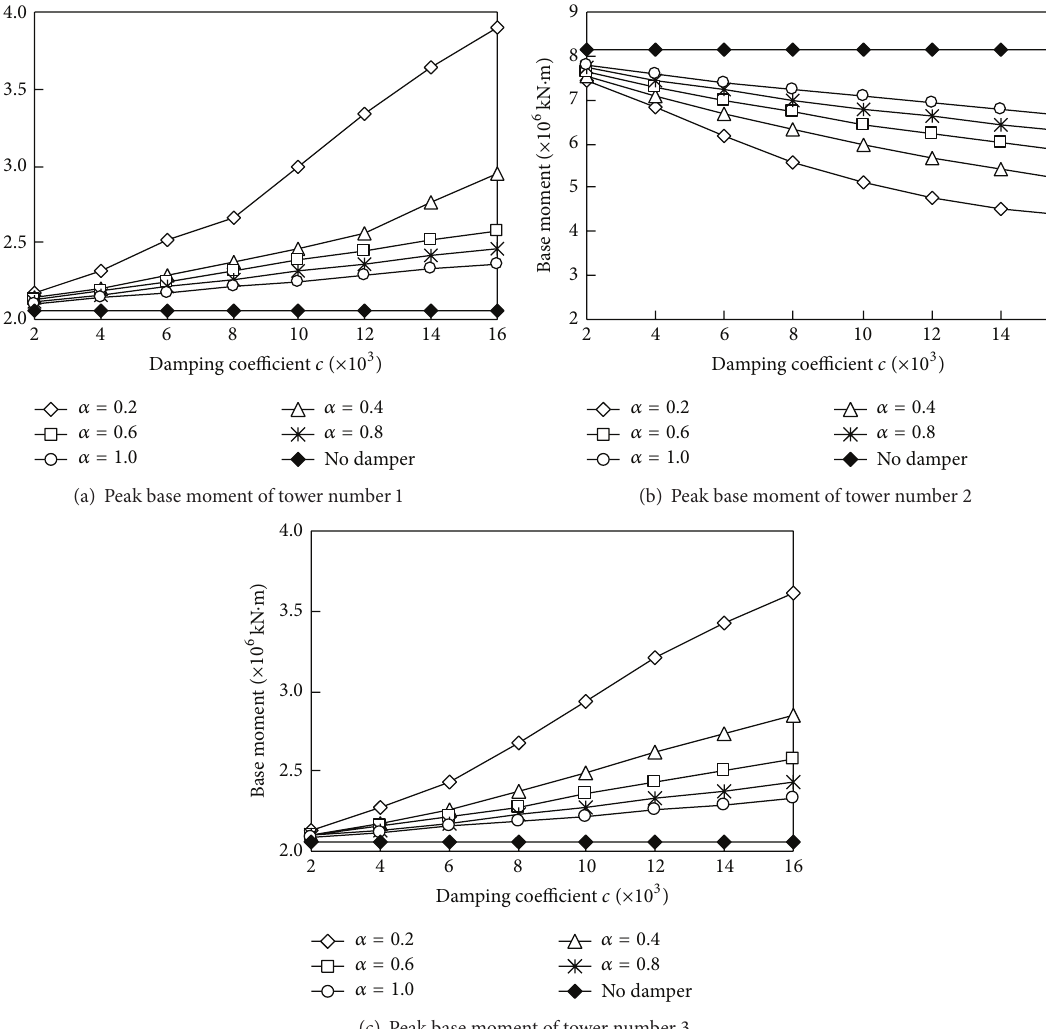
Figure 8: Effects of variations in damping coefficient and velocity exponent of the viscous fluid dampers on the peak base moments of bridge